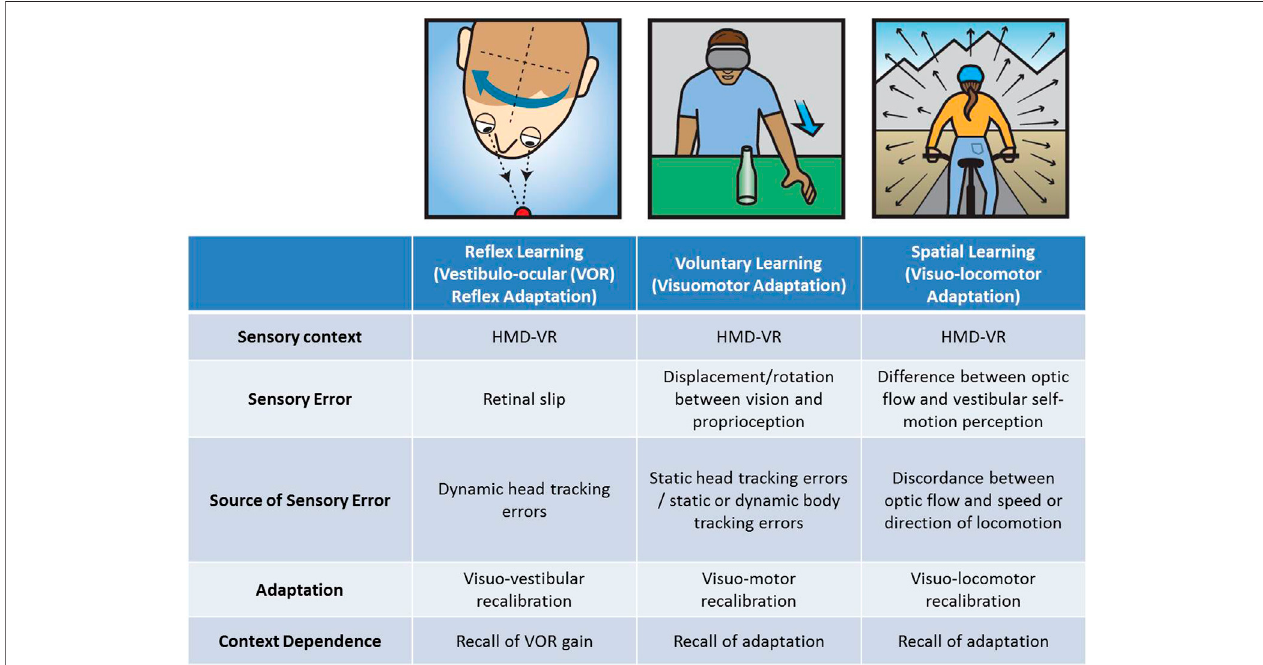
FIGURE 2 | Three examples of context-speci fi c learning in head-mounted display-based virtual reality (HMD-VR).